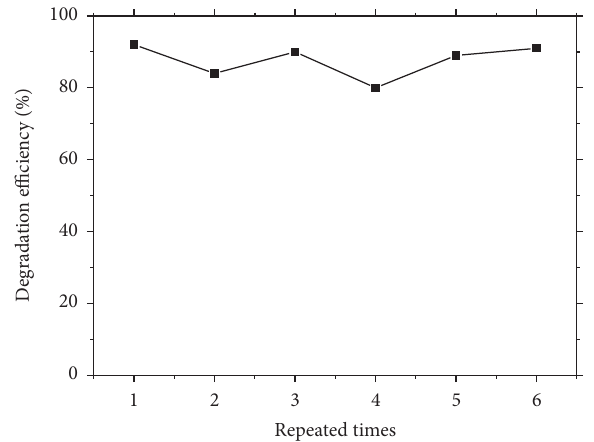
Figure 10: The photodegradation activities of immobilized PU/TiO 2 after being used repeatedly.